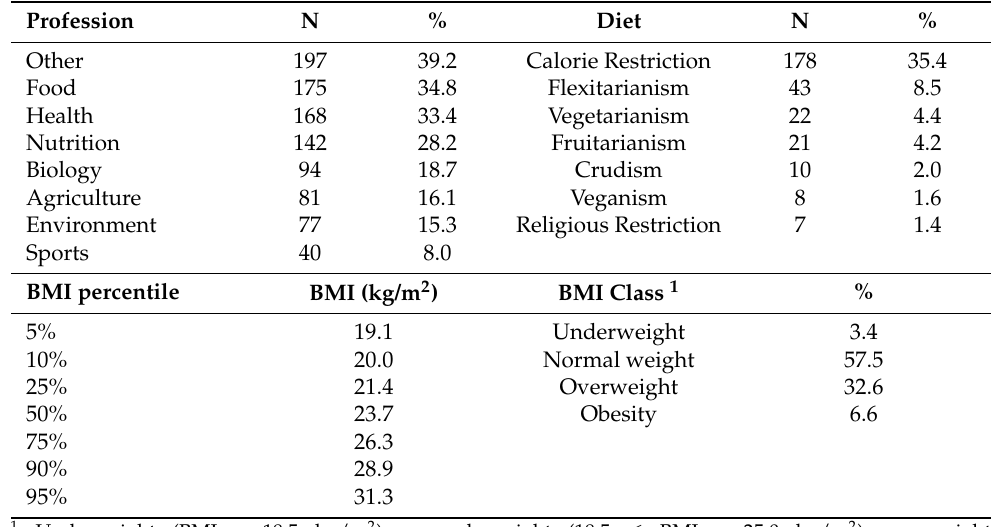
Table 3. Anthropometric and behavioral characterization of the sample at